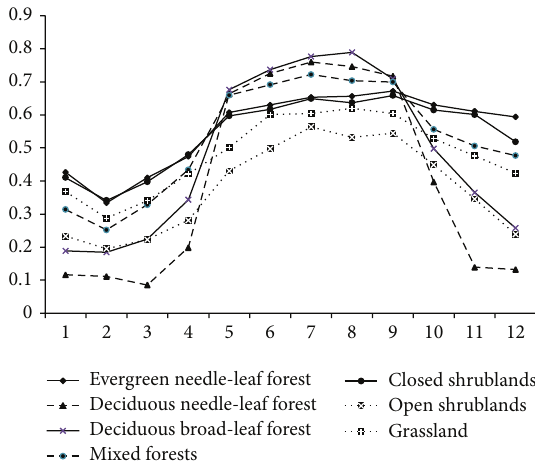
Figure 7: The NDVI characteristics of different vegetation